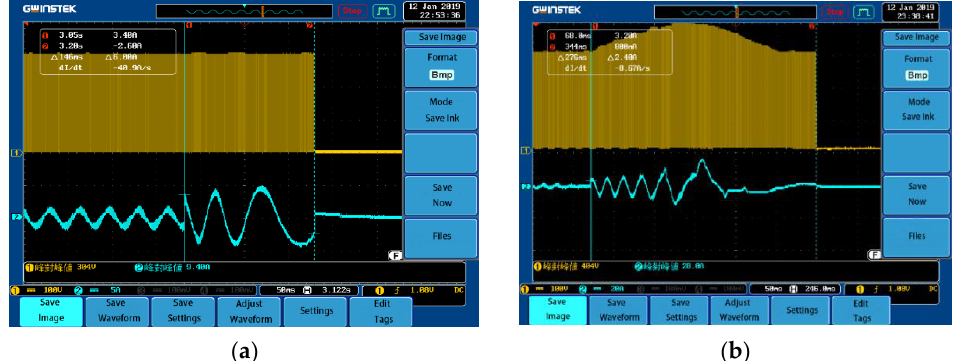
Figure 13. PMSM working under the FOC reverse-braking mode. ( a ) 450 rpm; ( b ) 950 rpm.